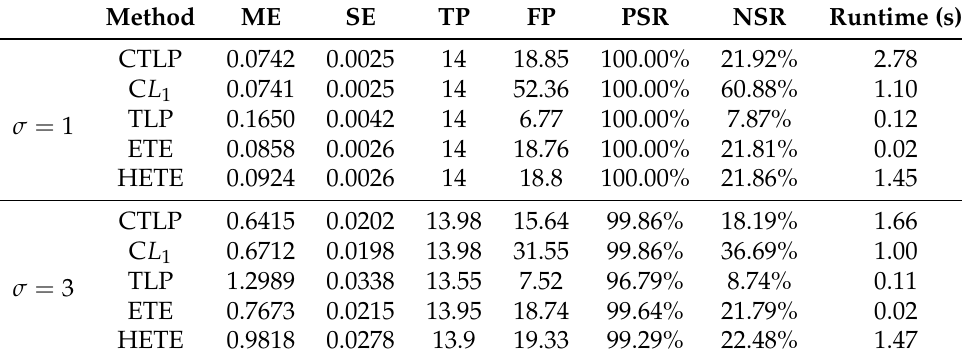
Table 2. The comparison of five methods in the case of n > p , independent correlation matrix.